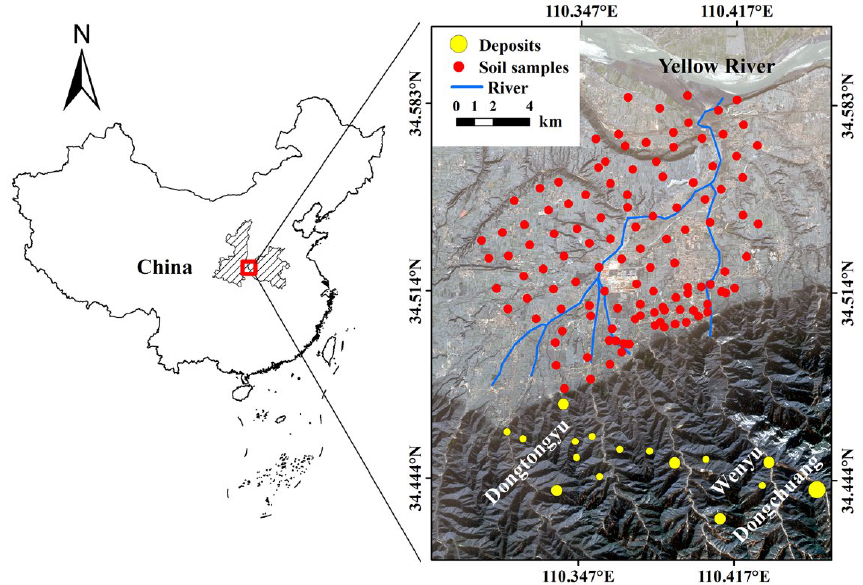
Figure 1. Study area and sample location (red dots). Small, medium and large yellow circles represent the relative size of Au deposits. Blue polylines mark the main river channels.